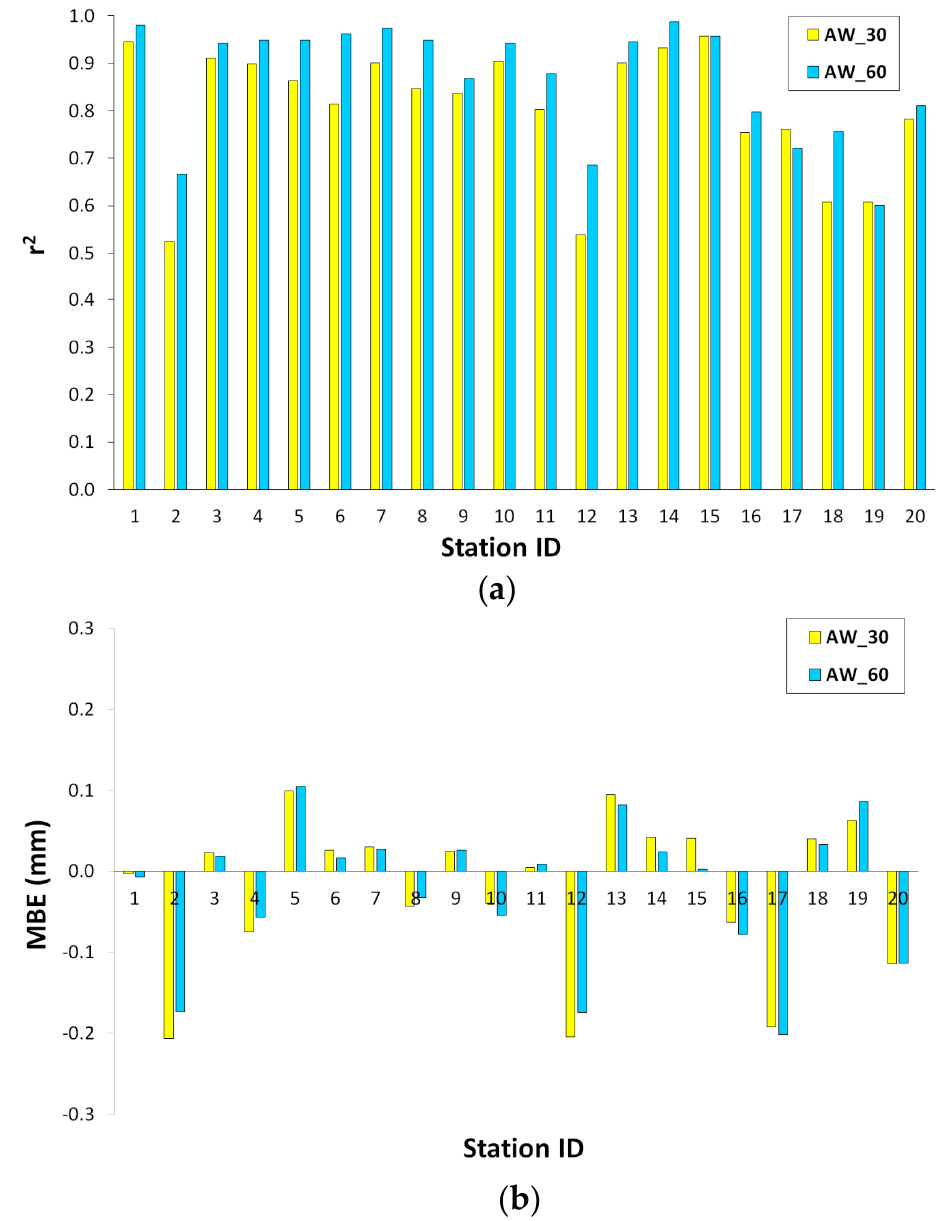
Figure 4. Histograms showing the determination coefficient (r 2 ) ( a ) and the mean bias error (MBE) ( b ) computed between AW computed over 30 and 60 days using ground and combined meteorological data (all correlations are highly significant, p < 0.01).